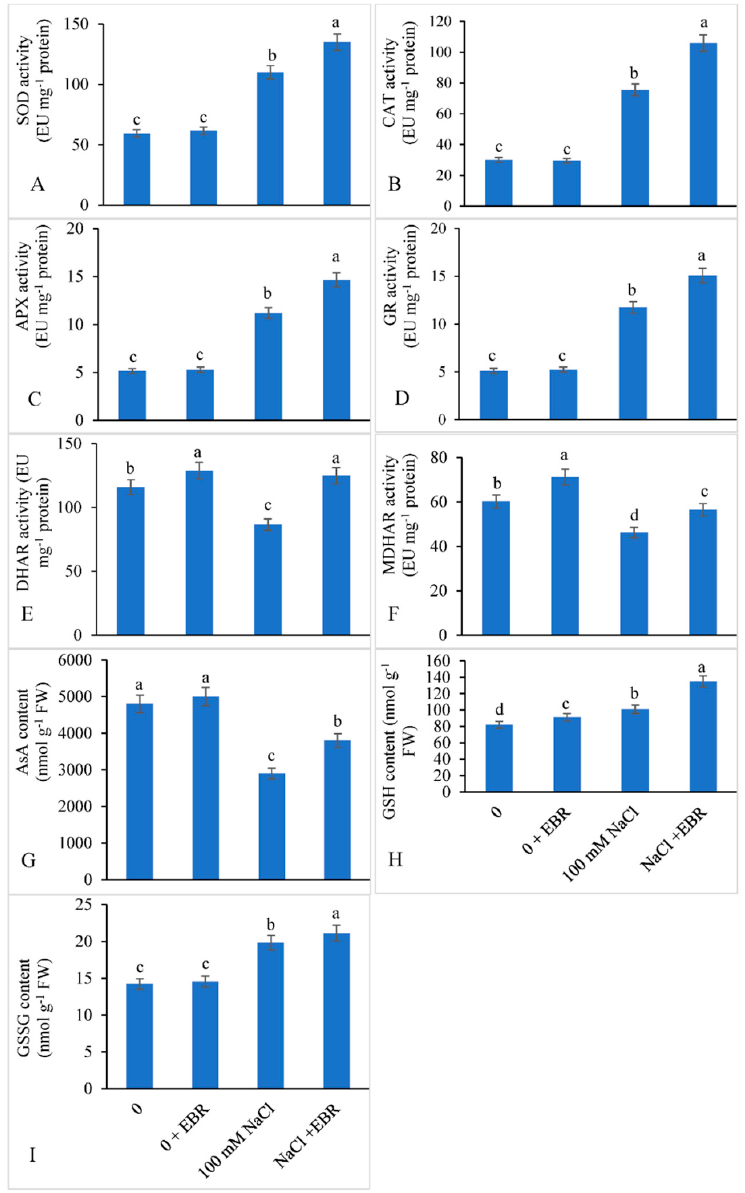
Figure 6. Exogenously applied 24-epibrassinolide (EBR) enhanced the activities of ( A ) superoxide dismutase (SOD), ( B ) catalase (CAT), ( C ) ascorbate peroxidase (APX), ( D ) glutathione reductase (GR), ( E ) Dehydroascorbate reductase (DHAR), ( F ) manodehydroascorbate reductase (MDHAR), ( G ) ascorbate (AsA) content, ( H ) glutathione (GSH) content, and ( I ) GSSG content in soybean plants under NaCl stress. Data presented are the means ± SE ( n = 5) and significant di ff erence between the means calculated at p ≤ 0.05 using the Duncan’s multiple range